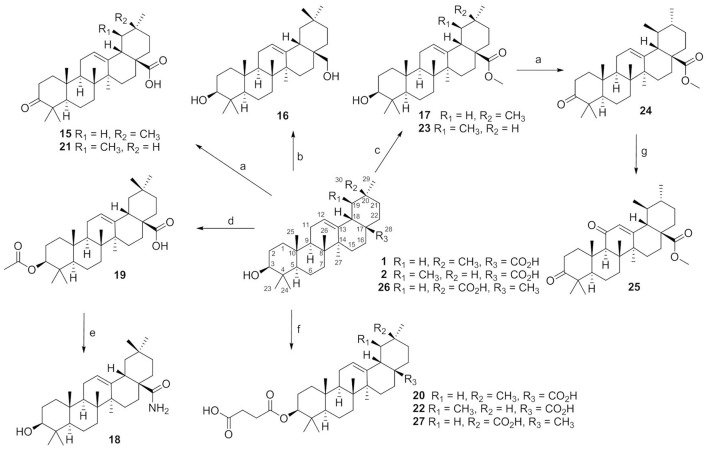
The synthesis routes for compounds 15–27. Reagents and conditions: (a) Jones reagent, acetone, 0°C, 1 h, 74–98%; (b) LiALH4, THF, rt, 24 h, 56%; (c) CH3I, K2CO3, acetone, rt, 12 h, 86–95%; (d) acetic anhydride, pyridine, rt, 12 h, 92%; (e) (COCl)2, CH2Cl2, rt, 2 h, then conc. ammonia, toluene, 4–8°C, NaOH, MeOH/THF, 40°C, 5 h, 42%; (f) succinic anhydride, DMAP, CH2Cl2, rt, 24 h, 87–97%; (g) CrO3, Ac2O, AcOH, rt, 3 h,50%.